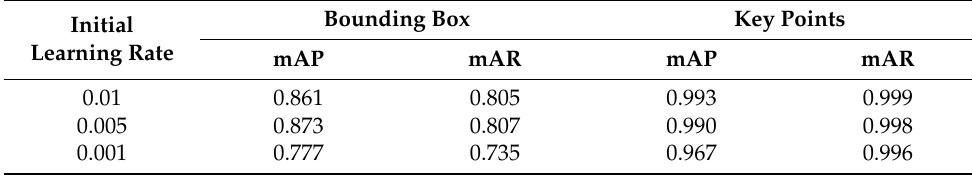
Table 4. Model performance with different initial learning rate.